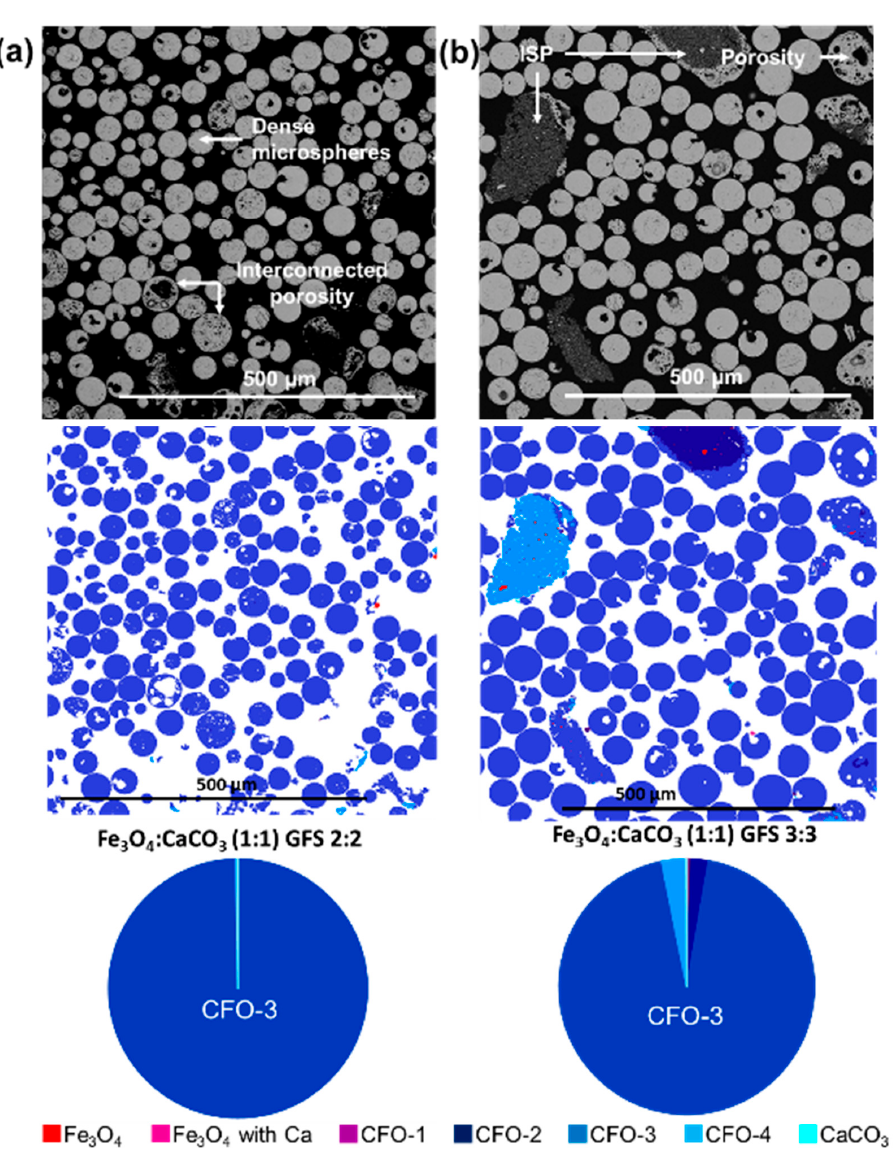
Figure 6. BSE images, MLA compositional analysis and associated pie-charts showing the mineral proportions (wt%) of flame-spheroidised Fe 3 O 4 :CaCO 3 (mass ratio 1:1) microspheres: ( a ) 2:2 and ( b ) 3:3, following sieving and sectioning, illustrating microspheres, porosity and minerals obtained. Mineral references shown on Table S2. GFS: gas flow se tt ing.